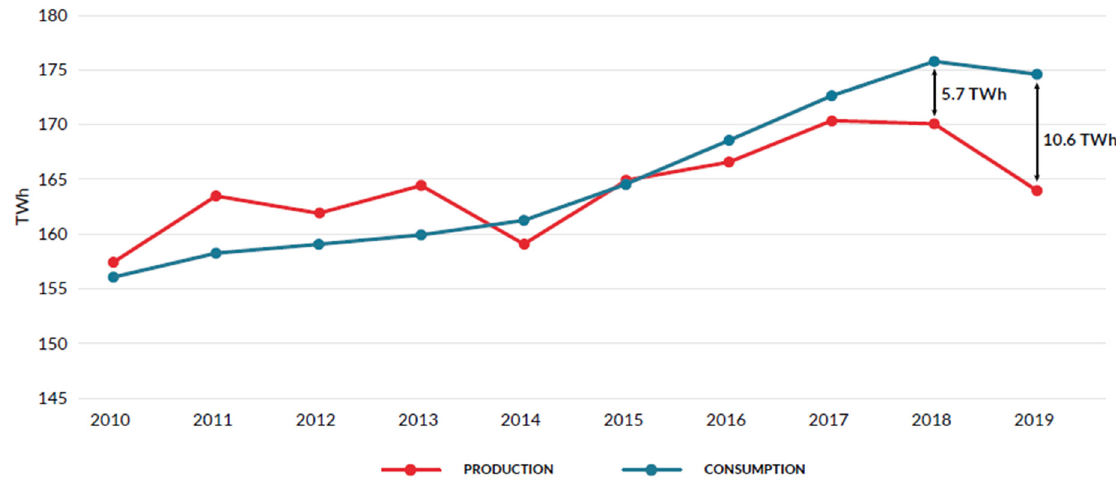
Figure 5. Balance of domestic electricity production and consumption [73].